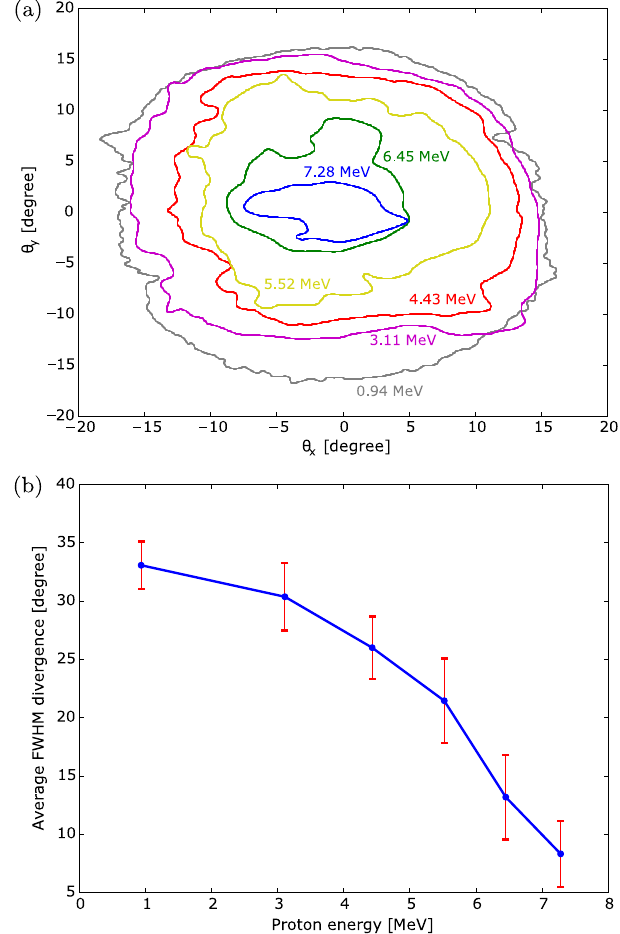
FIG. 1. (a) Energy dependent divergence of the proton beam source. The contours drawn are the isodose lines at 50% of the maximum dose, and the labels indicate the minimum energy required for a proton to reach the considered radiochromic film. (b) Average divergence of the proton beam, calculated from (a) as function of its